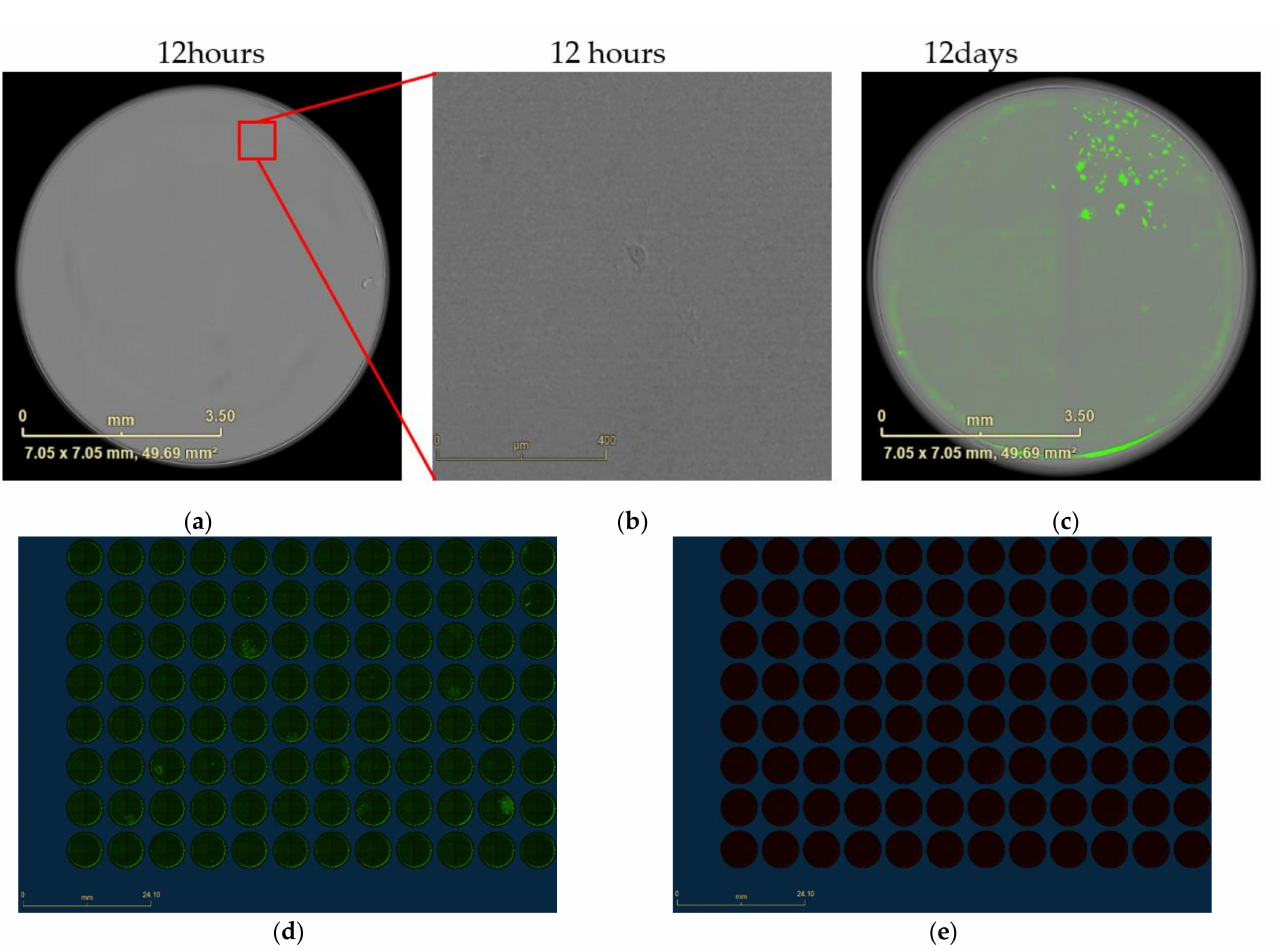
Figure 4. Steps of IncuCyte ® S3 whole well image for the 96 wells plate scanning. ( a ) Put the 96-well plate into the IncuCyte ® S3. ( b ) Select the image channels. ( c ) Chose the vessel location. ( d ) Select the wells for scanning.